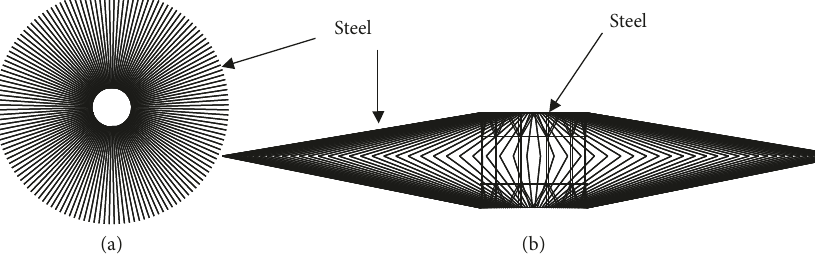
Figure 23: Roof structural view. (a) Top view. (b) Side elevation.